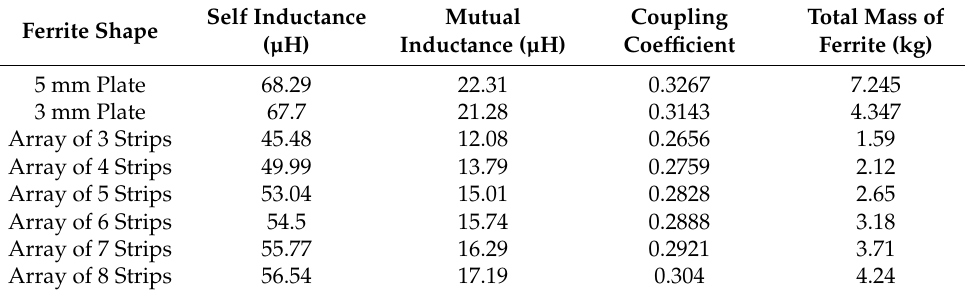
Table 5. Simulation results of various ferrite structures.